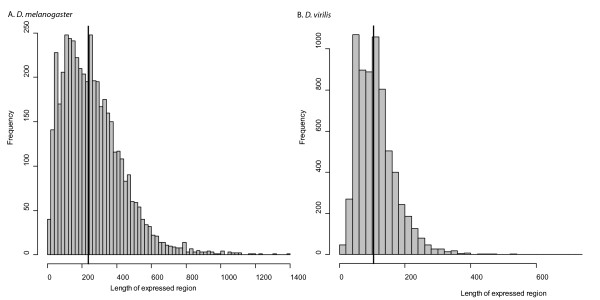
Distribution of lengths of expressed regions. Histogram of the lengths of expressed regions in A) D. melanogaster and B) D. virilis. Solid black lines show the median of each distribution.